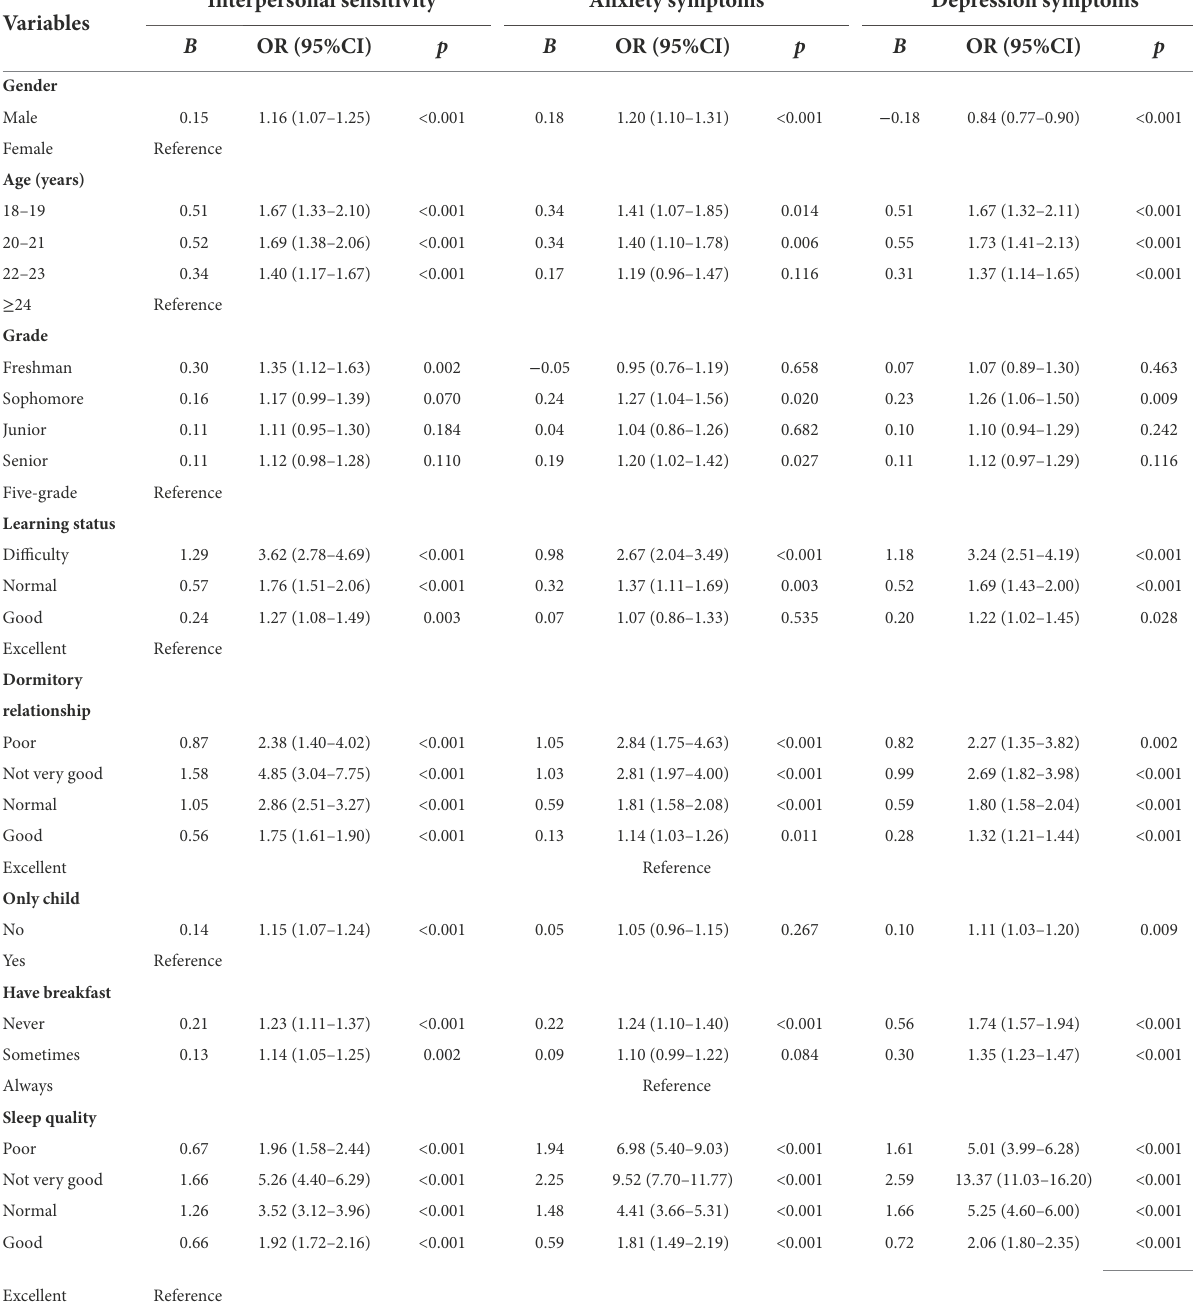
TABLE 3 Logistic regression analysis of interpersonal sensitivity, anxiety symptoms and depression